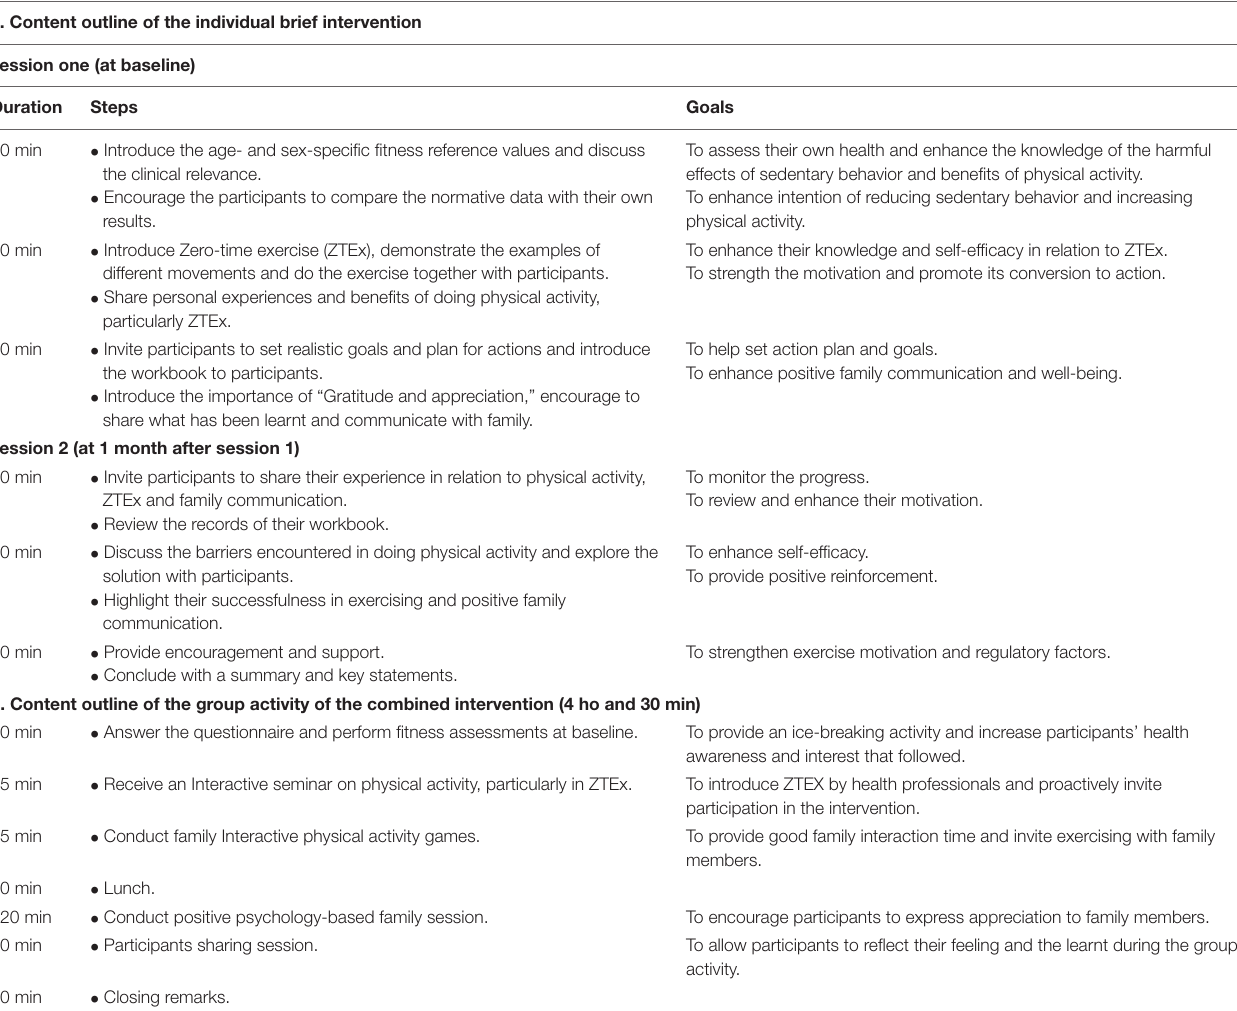
TABLE 1 | The content outline of individual brief intervention and group activity of combined